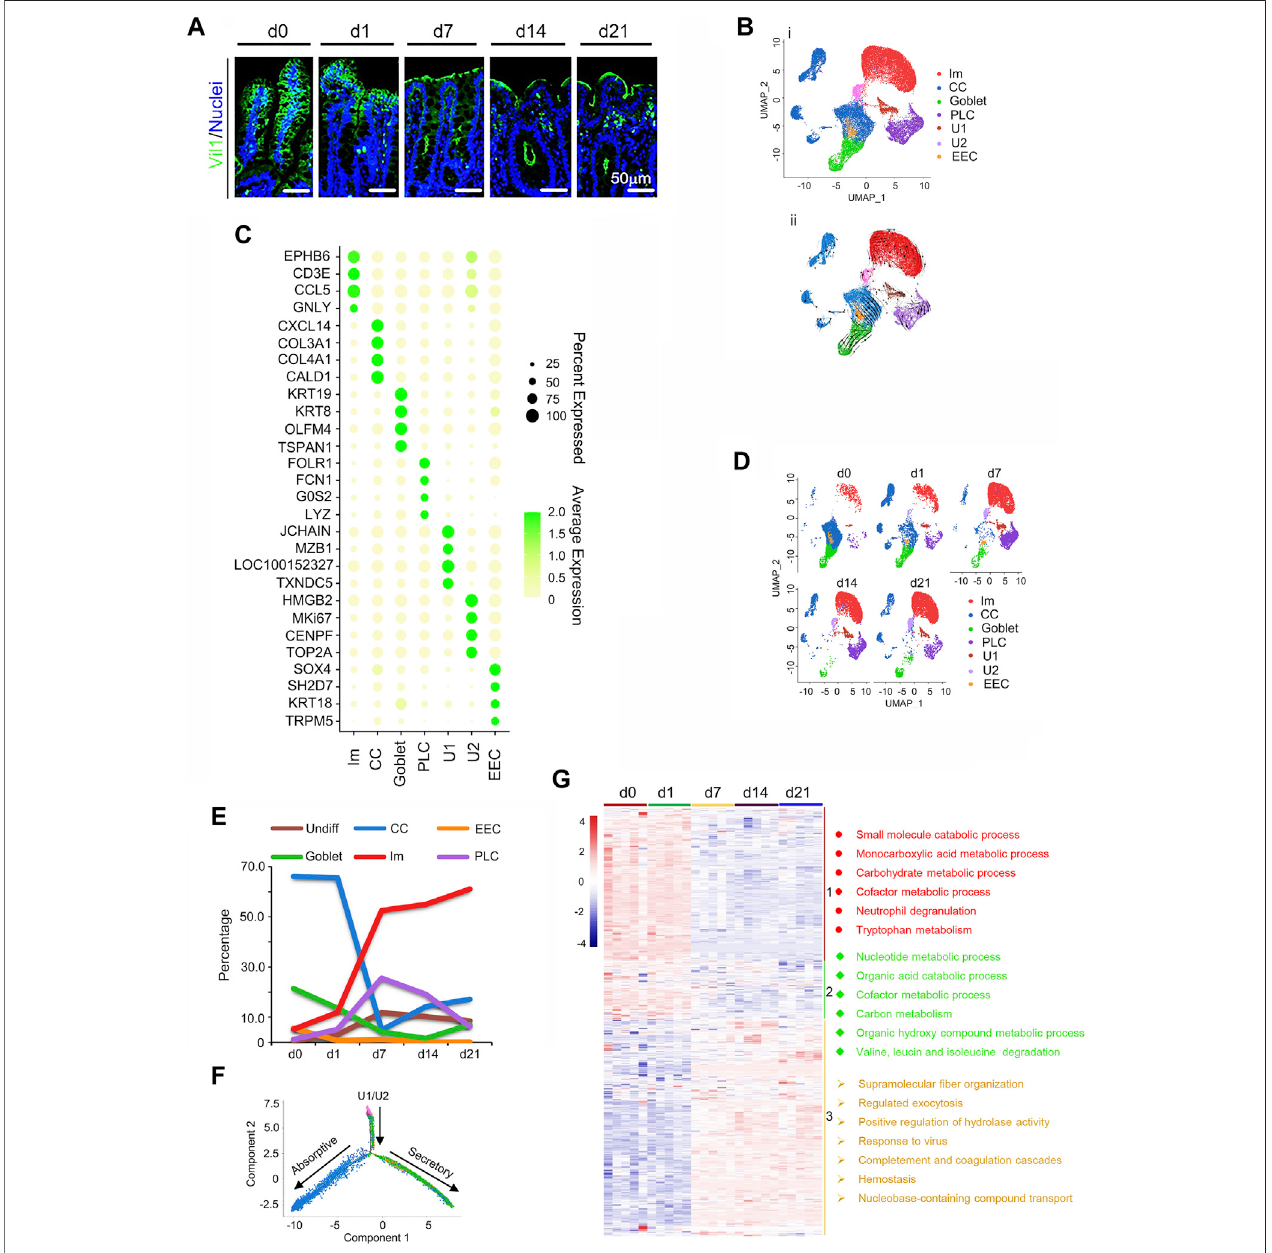
FIGURE1| Single-cellpro fi leofswineneonatalcecalepithelium. (A) Vil1stainingofthececaat5timepointsincecalsamples.Scalebar:50 μ m. (B) Cecalcelltype clusters (Allthe cells pooled together to show the major cell clustersfor the fi ve timepoints).(i). UMAP of32 686 single cells (points), colored by cluster assignment ( n = 5 pigletsateach timepoint).(ii)RNAvelocity vectorprojectiononUMAPplot(Thearrow indicatedthedevelopmentaltrend). (C) Heatmap ofclustermarkergenes,colored by relative gene expression. Dot size represents the fraction of cells per cluster. The color scale bar represented the average expression. (D) Cell population changesduringdevelopmentbyUMAPanalysis(fromd0tod21). (E) Theproportionofcellsineachclusterateachtimepointtoshowthetrendoftherelativepercentage ofcellsfromd0tod21. (F) Differentiationpseudotime trajectoryanalysisofabsorption and secretorycells(CCs, goblet,PLCs,and EECs) fromundifferentiatedcells(U1/ U2).Predictedsecretory-lineagecellsandabsorptivecellsarefrom U1/U2. (G) Proteomics dataofpigletcecalmucosaat 5time points( fi veanimalsamplesat eachtime point) with enriched functions for each group ofproteins. Three clustersofproteins indicated by thedifferent colorbar on theright, and with the enriched main functional pathways.